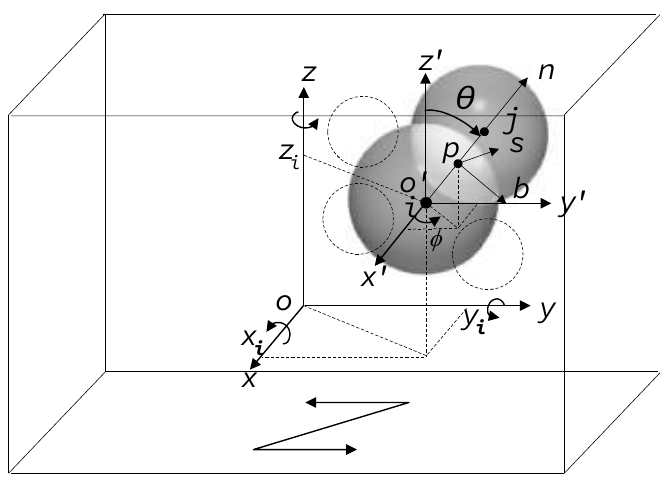
Figure 1. Image of contact condition of two particles in a container.